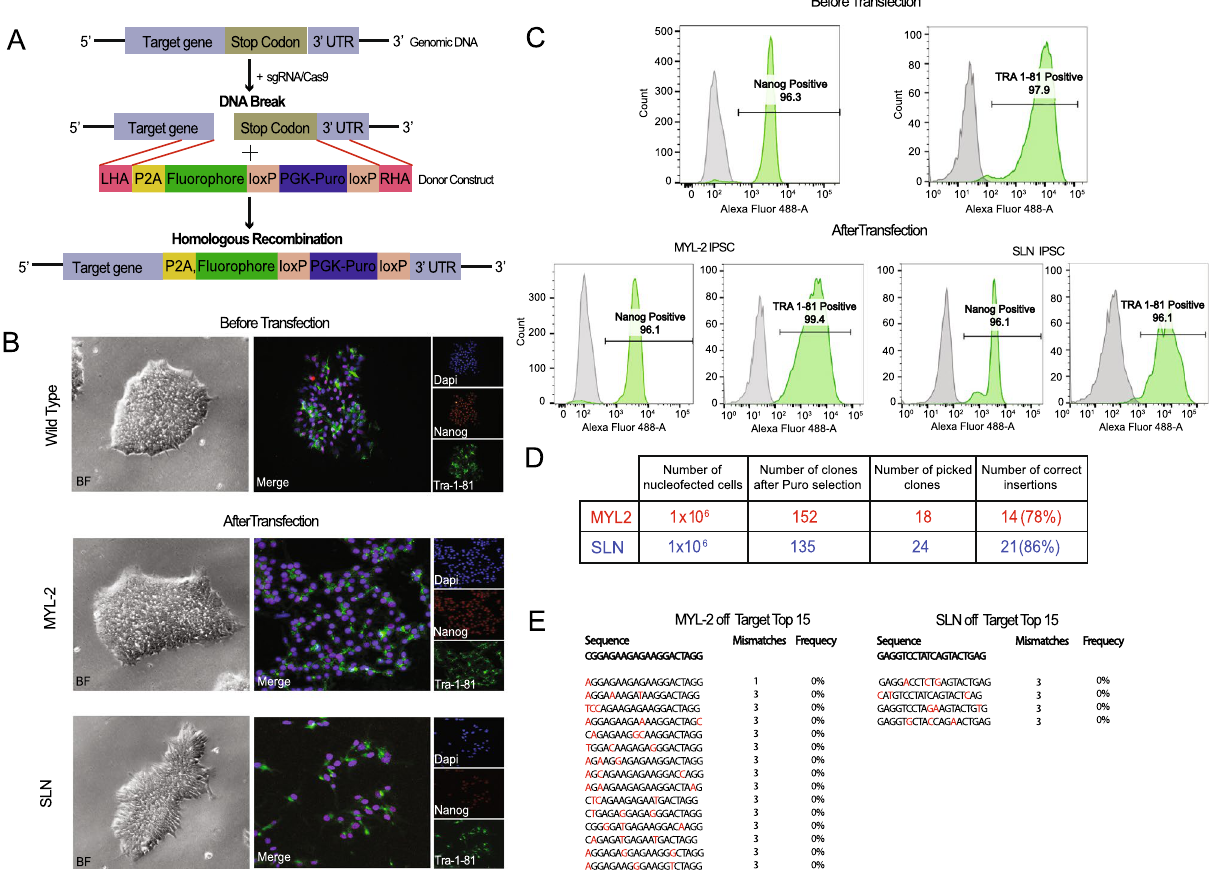
Figure 1. Generation of stable ventricular and atrial reporter lines in human iPSCs. ( A ) Diagram of the CRISPR-Cas9 donor construct design for both the MYL-2/tdTomato and SLN/eCFP. ( B ) Representative images (bright field/Immunofluorescence) of hiPSCs immunostained for pluripotent markers Nanog (red) and Tra-1– 81 (green) before and after transfection of donor constructs. ( C ) Representative flow cytometry plots of hiPSCs immunostained for pluripotent markers Nanog and Tra-1–81 before and after transfection. ( D ) A table listing the transfection efficiencies for the development of the MYL-2/tdTomato and SLN/eCFP reporters. ( E ) A list of the top off-target sites (MYL-2 = 15 and SLN = 4) of which had 3 or less base pair mismatches from the targeting guide (red) tested on 10 positive clones